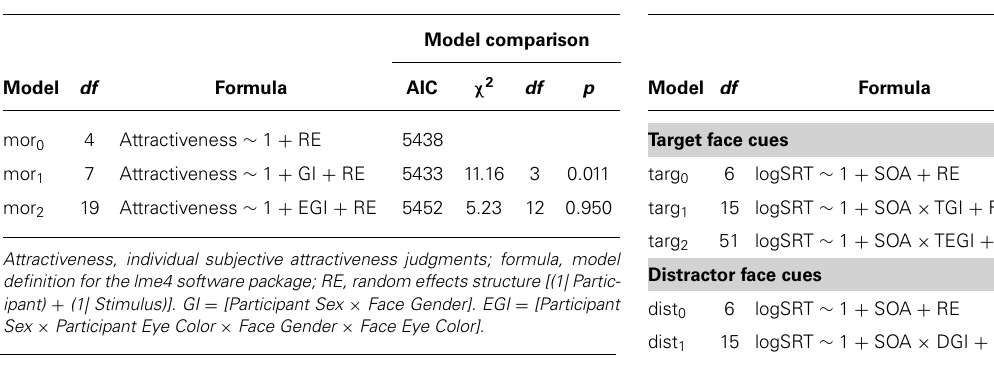
Table 4 | Comparison of nested LMMs fitted to ratings of morphed faces in Experiment 2.